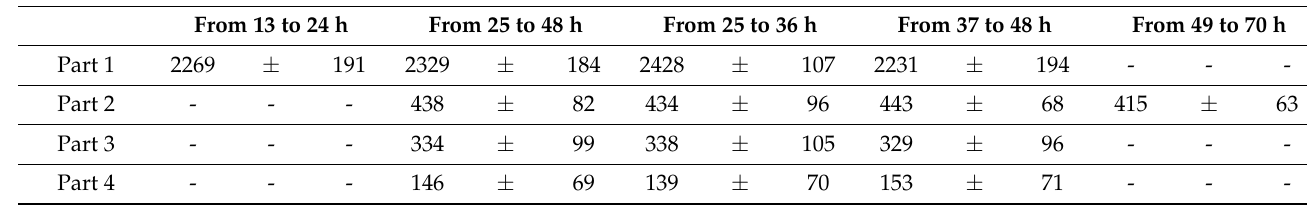
Table A1. Average and standard deviation of radon activity concentrations in different intervals of experiment 13 (Table 2 and Figure 2b) demonstrate that equilibrium conditions are already reached after 24 h from the beginning of each part. Time counting is continuous within each test and not interrupted at the end of the single experimental